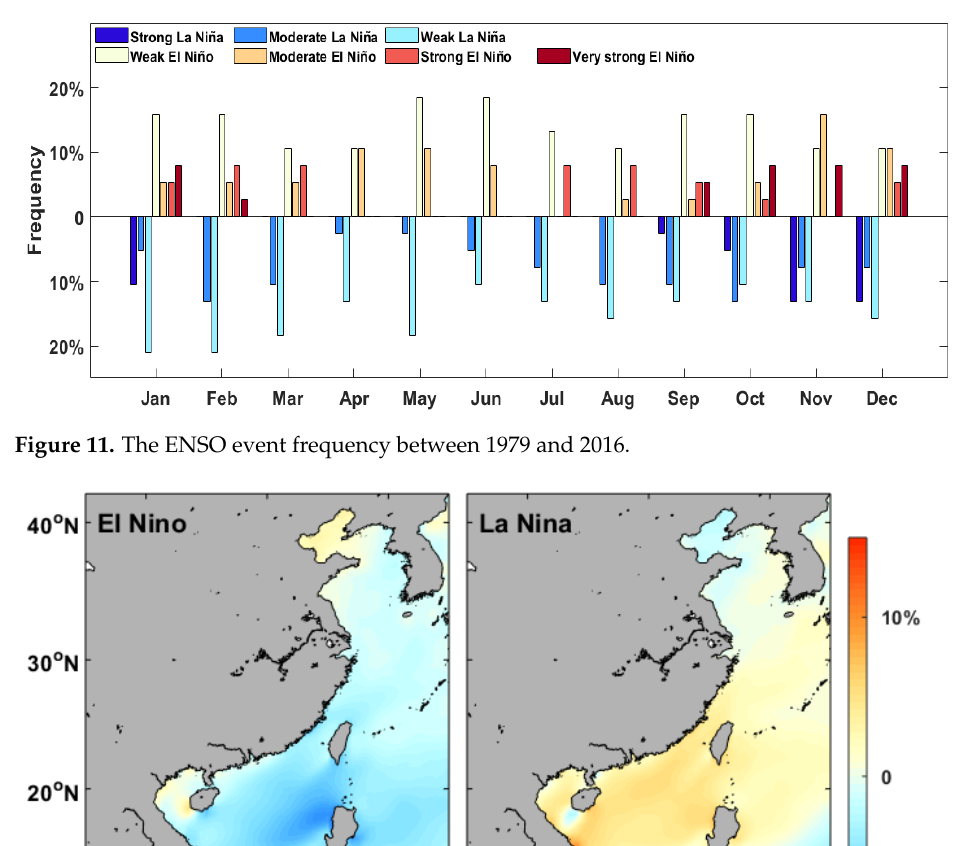
Table 2. Classification of ENSO event intensity using the ONI index (the ONI in the range [ – 0.5 0.5] denotes the normal status).